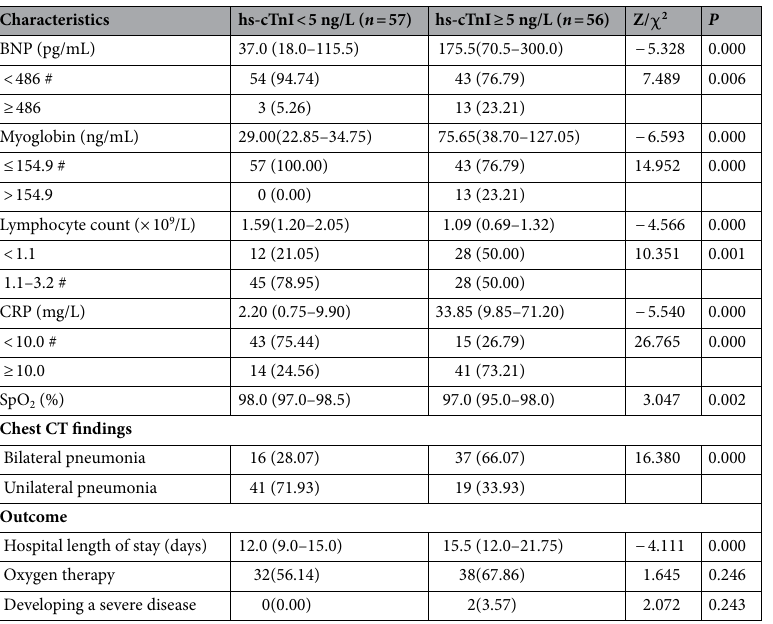
Table 3. Comparisons of BNP, myoglobin, CRP, lymphocyte count, SpO 2 , radiological findings, and outcome between patients with hs-cTnI under 5 ng/L and ≥ 5 ng/L. Data are shown as median (interquartile range) or n (%). P values were calculated by Mann–Whitney U test, χ 2 test or Fisher’s exact test, as appropriate. BNP, B-type natriuretic peptide; CRP, C-reactive protein; SPO 2, pulse oximeter O 2 saturation; * denoted P < 0.05; # denoted Reference intervals of